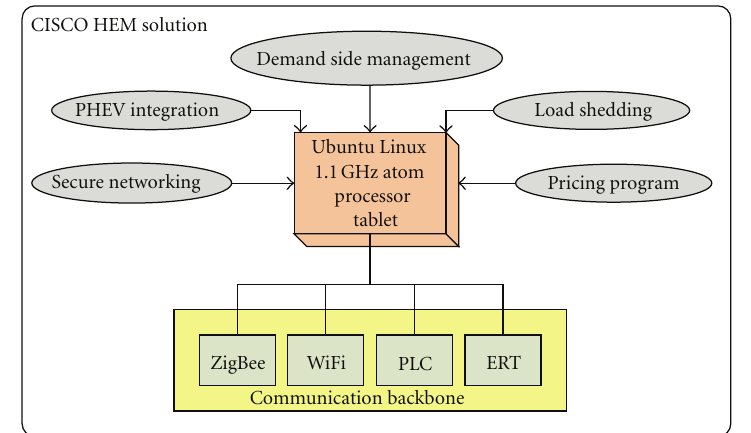
Figure 5: Ciscos HEC architecture.